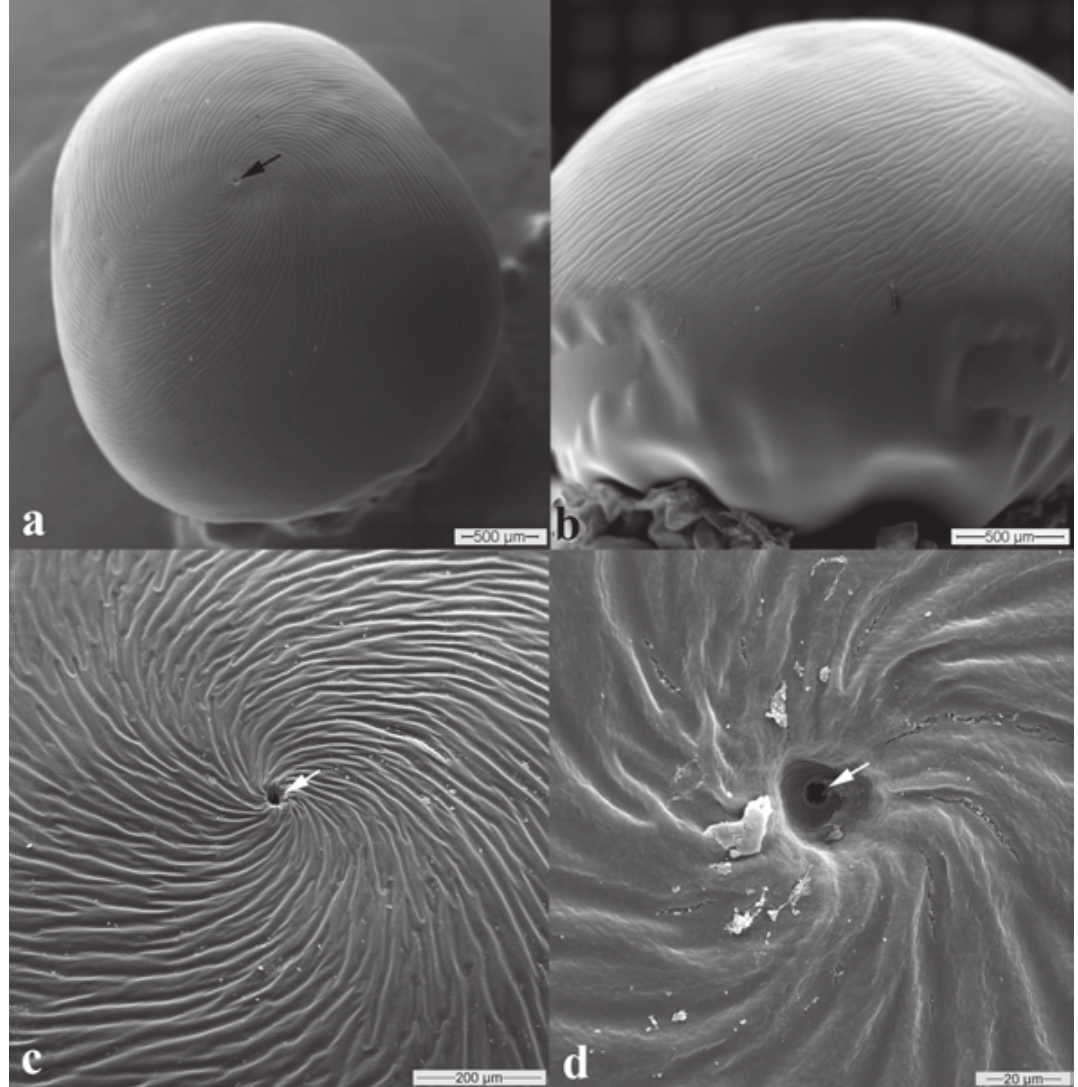
Fig. 2. Scanning electron micrographs of eggs of Thalassophryne amazonica . a , View on animal egg pole showing ridges and intermittent grooves forming a spiralling pattern towards the micropyle (marked by arrow). b , sideview of the equatorial region of the egg illustrating the start of the ridge and groove system at the widest part of the egg, the smooth surface area towards the vegetal egg pole and the adhesive foot. c , micropylar area with spiralling ridges and grooves, micropylar pit marked by arrow. d , deep micropylar pit with micropylar opening (marked by arrow) at its